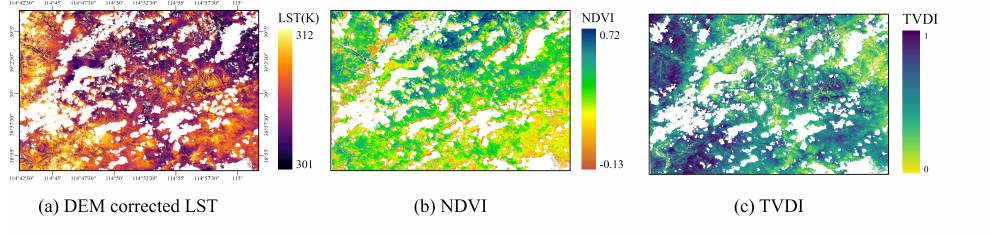
Figure 8. Input data (( a ) 10-m DEM Corrected LST, ( b ) 10-m NDVI) and output data (( c ) 10-m TVDI) of TVDI method in downscaling